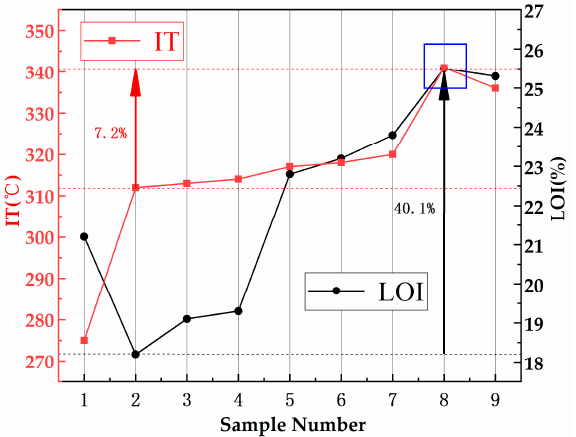
Figure 3. The value of IT and LOI of asphalt binder.